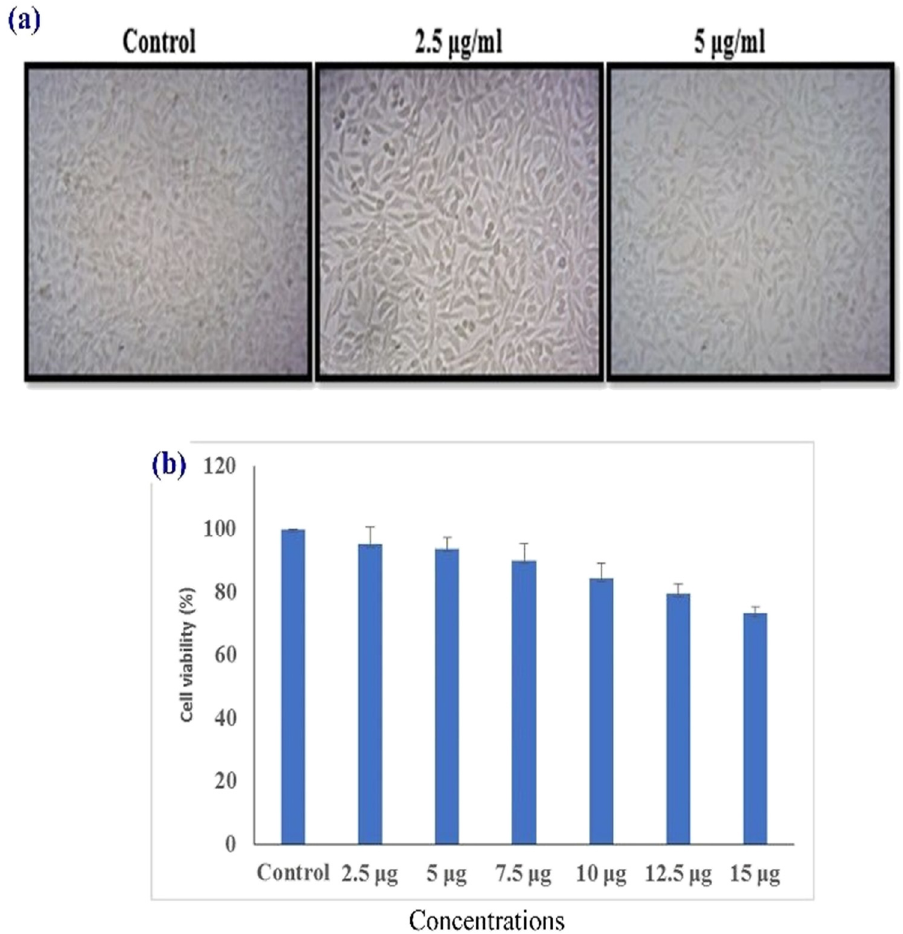
Figure 6: ( a ) Morphological changes in control and AS - ZnONPs treated Normal fi broblast L929 cells for 24 h. ( a ) Photomicrograph ( 20 ×) represents the morphology of AS - ZnONPs treated with L929 cells. ( b ) AS - ZnONPs treatment did not show any toxicity and cell changes to the L929 cells, assay. Various concentrations of synthesized zinc oxide nanoparticles and their mode of healing e ffi cacy against human fi broblast ( L929 cell line ) are graphically